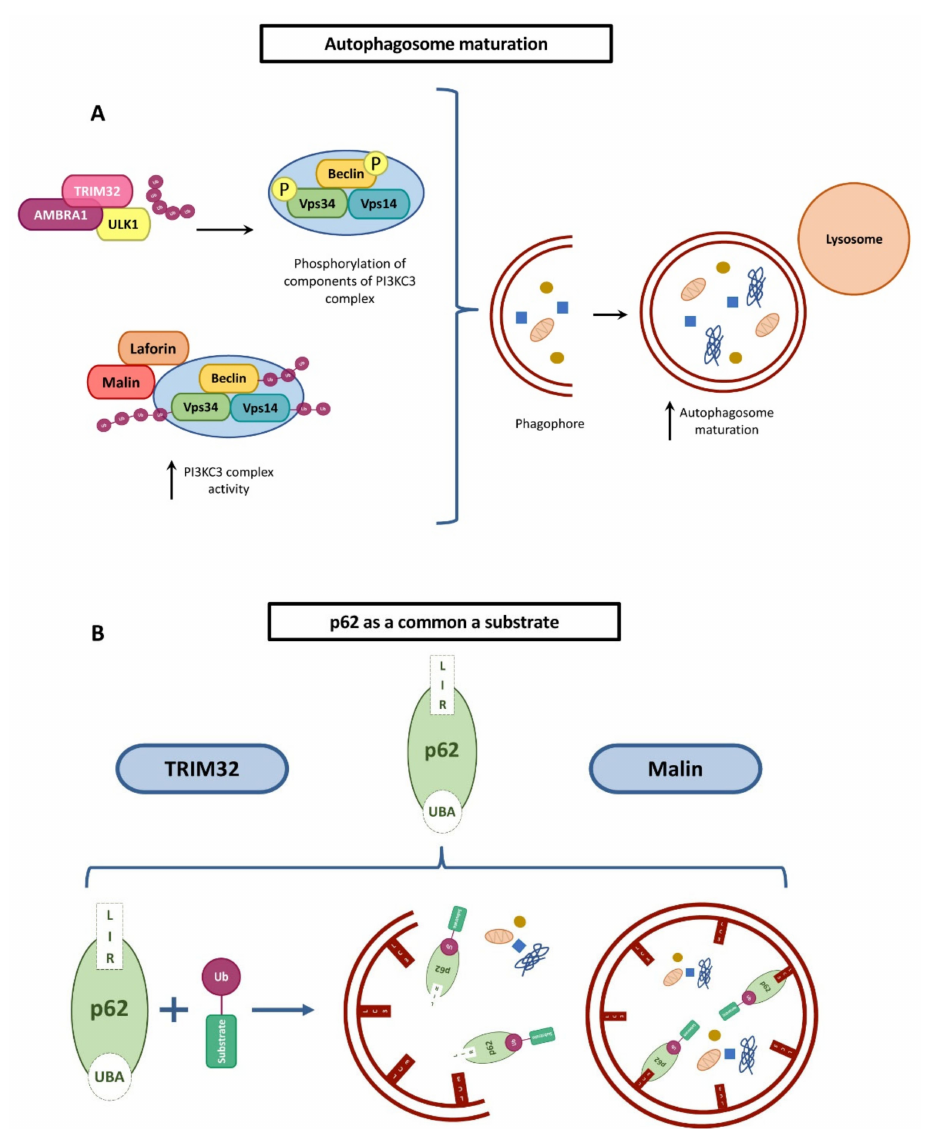
Figure 7. Common roles of TRIM32 and malin in regulating autophagy. Panel ( A ), initial steps of autophagosome formation. The laforin–malin complex regulates the initial steps of autophagosome formation through the assembly of a stable PI3KC3 complex. Similarly, TRIM32 affects the initial steps of autophagosome formation by regulating ULK1 function. Panel ( B ), p62 is a common substrate of TRIM32 and malin. The p62 autophagy receptor is involved in the recognition of ubiquitinated cargo proteins through the UBA domain. Then, p62 recruits the cargo proteins to autophagosomes via its LIR domain, which interacts with LC3. p62 is ubiquitinated by TRIM32 and also by malin, but this modification leads to different outcomes, degradation of p62 in the case of TRIM32 and improvement of autophagy in the case of malin. A key component of the autophagy pathway is p62, also known as sequestosome- 1, which is encoded by the SQSTM1 gene. p62 is an autophagosome receptor